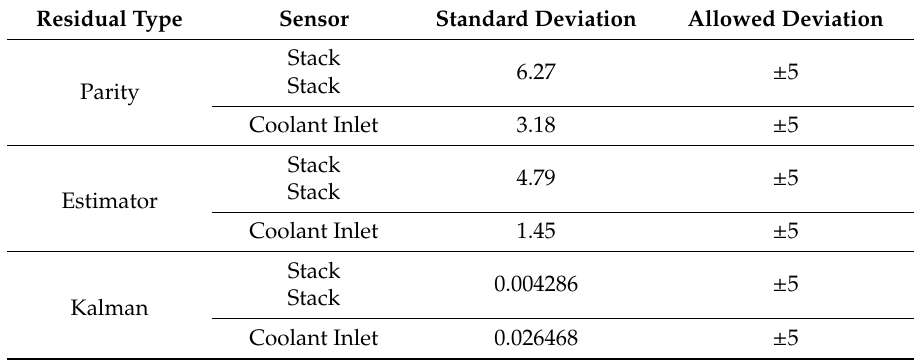
Table 2. Residual threshold value of stack and coolant inlet for three